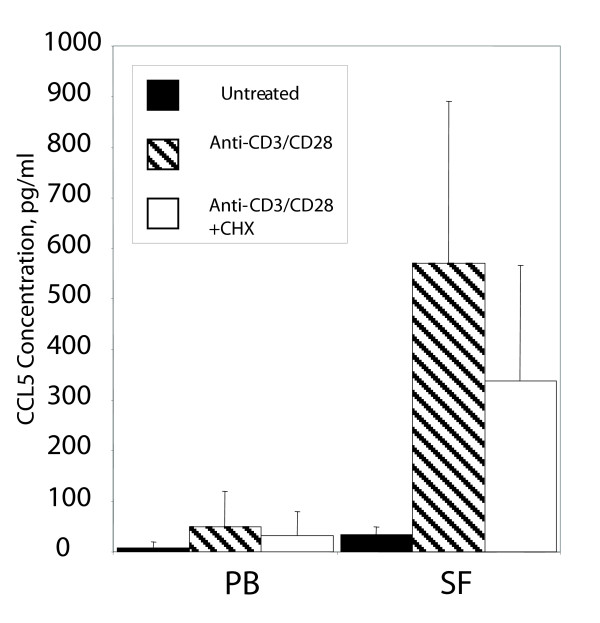
Release of CCL5 from synovial cells is very rapid and largely independent of new protein synthesis. Purified T cells from peripheral blood (PB) and synovial fluid (SF) were stimulated with anti-CD3 and anti-CD28, with (clear bars) or without (hatched bars) cyclohexamide (to block protein synthesis), or in control medium (black bars). Supernatants were assayed by standard ELISA for CCL5. Bars represent mean values of CCL5, and error bars one standard deviation.